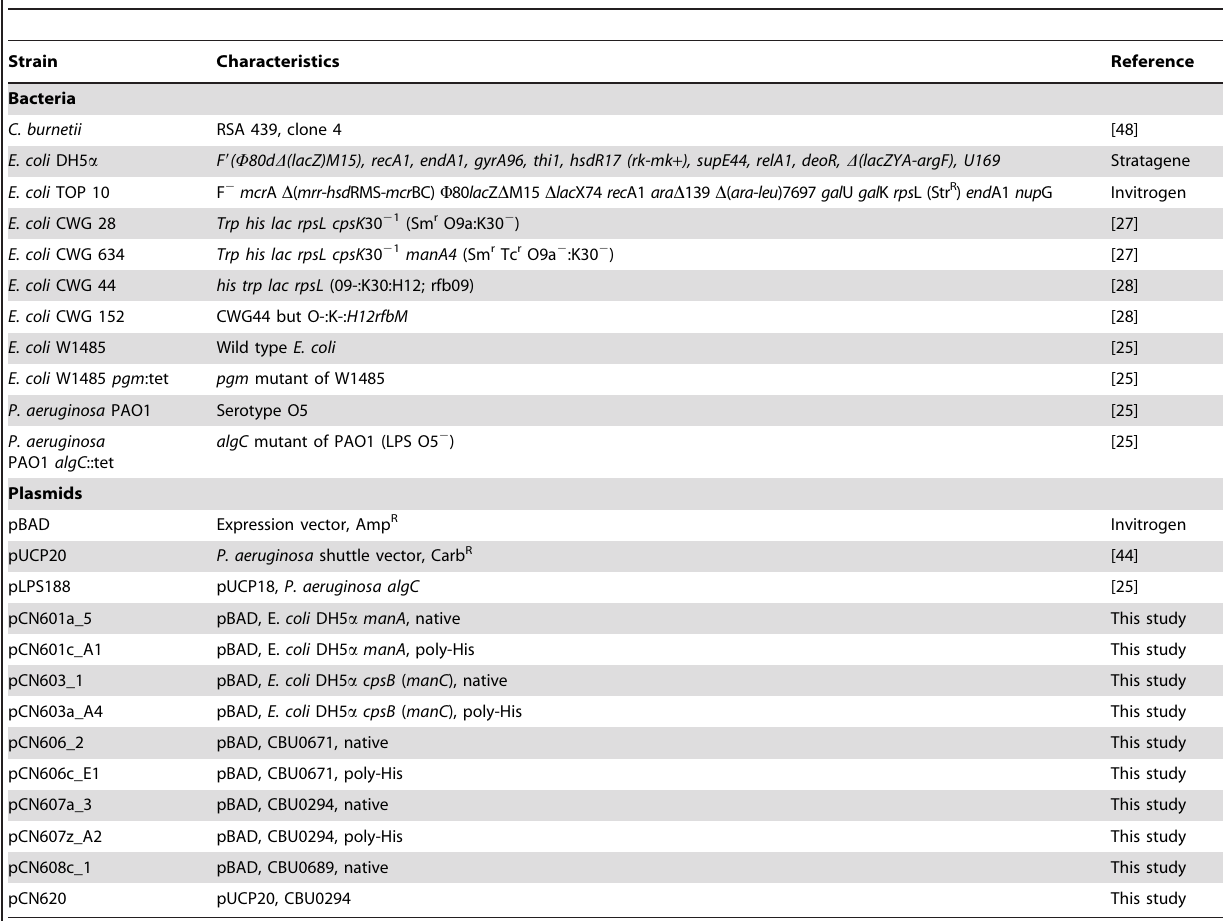
Bacterial strains and plasmids used in this study are described in Table 4. All bacterial strains were routinely propagated at 37 u C in Luria-Bertani (LB) broth or on LB-1.2% agar plates (Difco Laboratories). When necessary, ampicillin (100 m g/mL), carben- DNA isolation and manipulations were carried out in according to Sambrook and Russel (2001) [37]. Oligonucleotides used in this Table 4. Bacterial strains and plasmids used in this study.